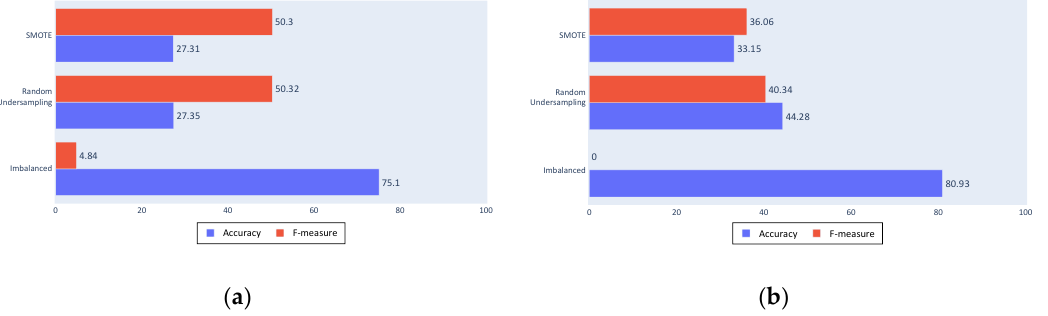
Figure 14. ( a ) No filtering decision tree results; ( b ) No filtering SVM results.